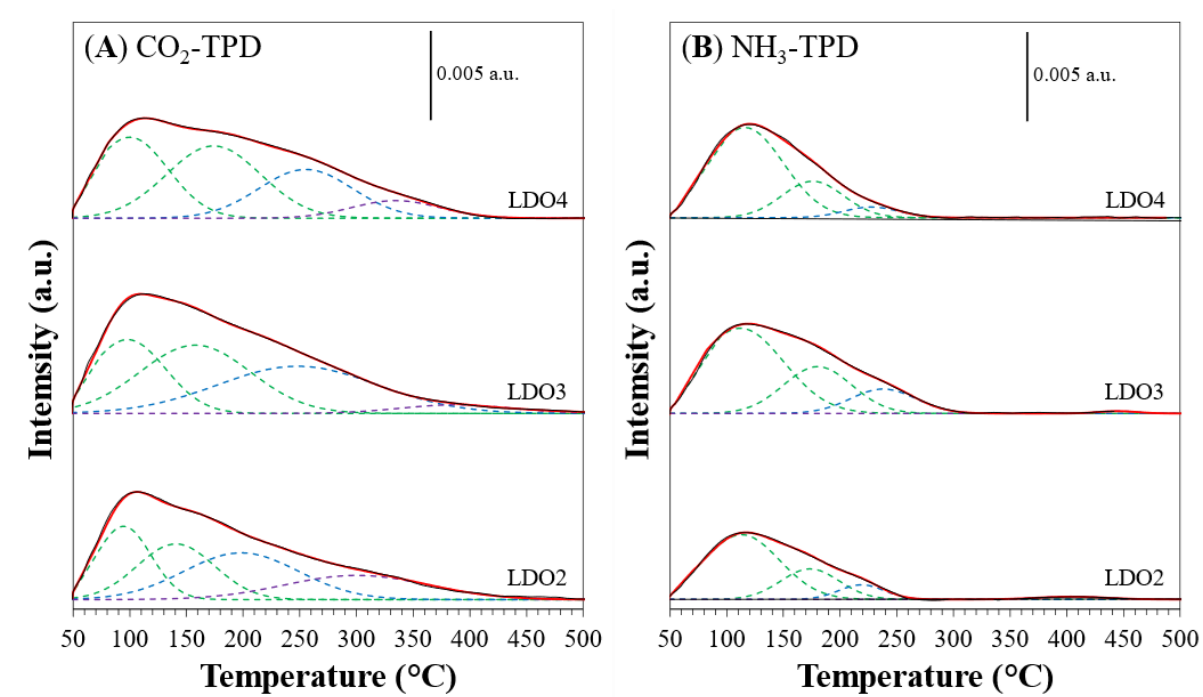
Figure 2. ( A ) CO 2 -TPD and ( B ) NH 3 -TPD profiles of calcined LDH samples. Green, blue and purple lines represent weak, medium and strong base or acid sites, respectively. Black and red lines are respectively the original data and the sum of deconvoluted peaks.